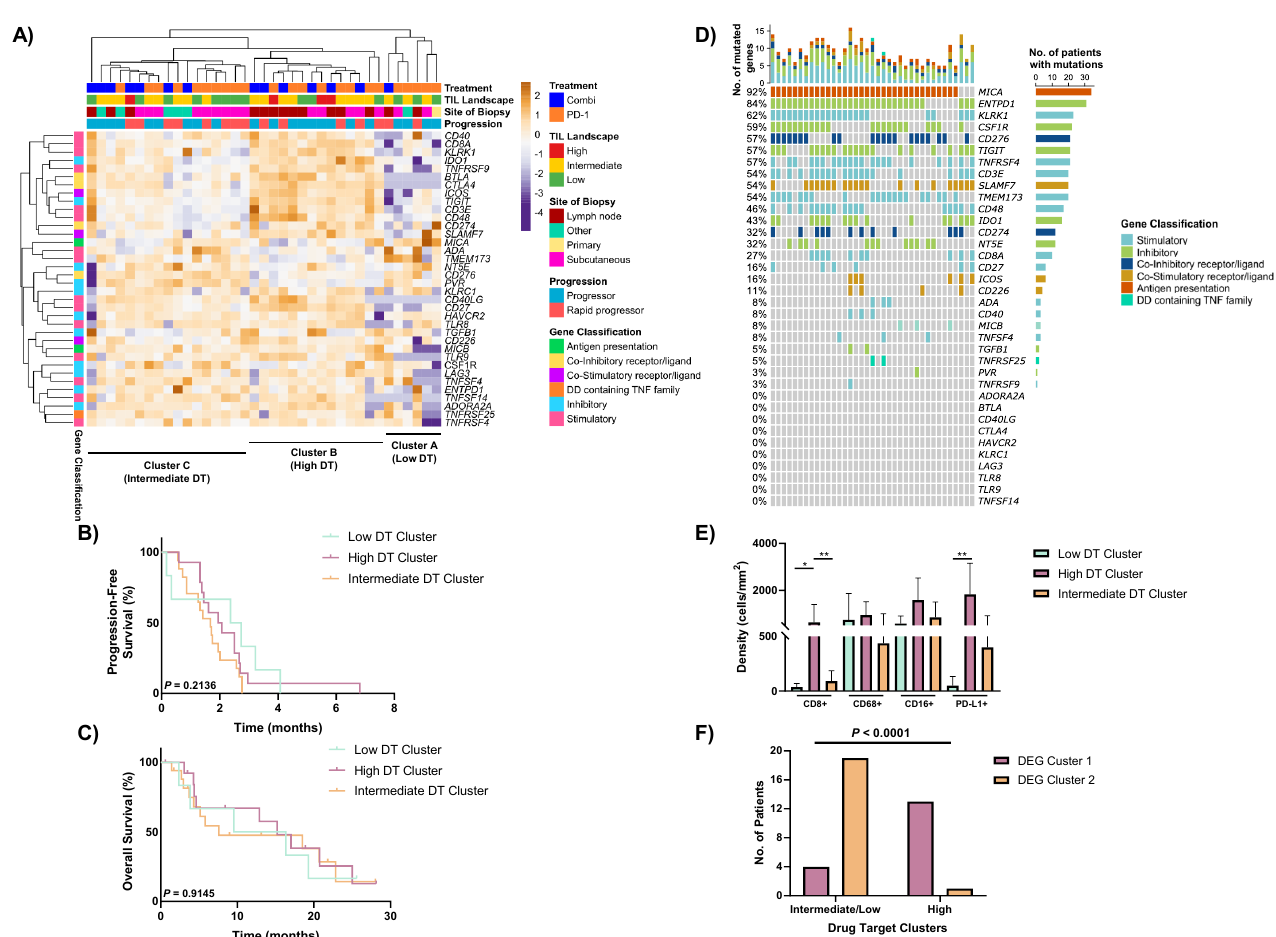
Figure 4. Gene expression of selected drug targets in non-responders. ( A ) Unsupervised hierarchical clustering of gene expression of 36 immune genes including drug targets in non-responders to anti-PD-1-based therapies. Kaplan–Meier curves illustrating no significant differences in ( B ) progression-free survival, or ( C ) overall survival between the three drug target (DT) clusters. ( D ) Oncoplot illustrating the positive expression of drug target genes (log2 counts > 4) in non-responders to anti-PD-1-based therapies. ( E ) Comparison of intratumoural immune populations (CD8, CD68, CD16 and PD-L1) from the multiplex immunohistochemistry between patients in the high DT cluster ( n = 11), intermediate DT cluster ( n = 12) and low DT cluster ( n = 5). ( F ) Bar graph illustrating the number of patients from the intermediate/low DT and high DT cluster in each DEG cluster, assessed using the Fisher’s exact test. Error bars represent mean ± SD. * p < 0.05, ** p <